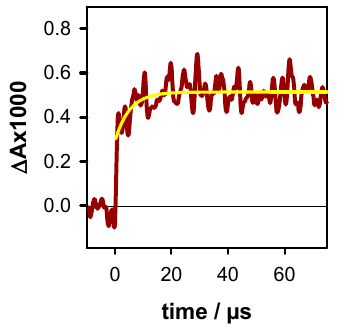
Figure 8. Formation of the ( G -H1) • radical in TEL21 / K + , estimated by the transient absorption signal at 720 nm. The yellow line is the fit with a mono-exponential model function. N 2 O saturated solutions. Table 2. Evolution of guanine radical populations in TEL21/K + , expressed as molar fractions of the initially generated radical concentration [R] 0 = [e hyd − ] 0 .